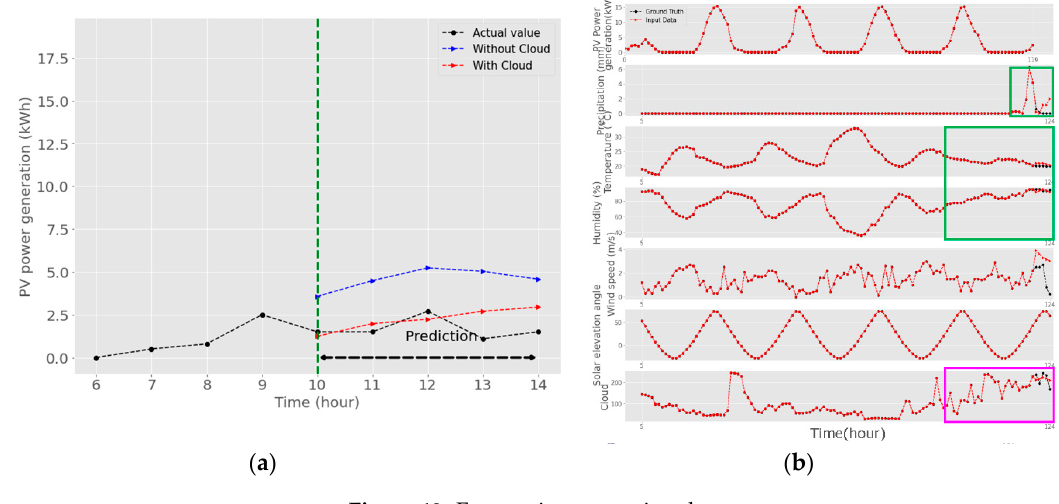
Figure 13. Forecasting on a rainy day.